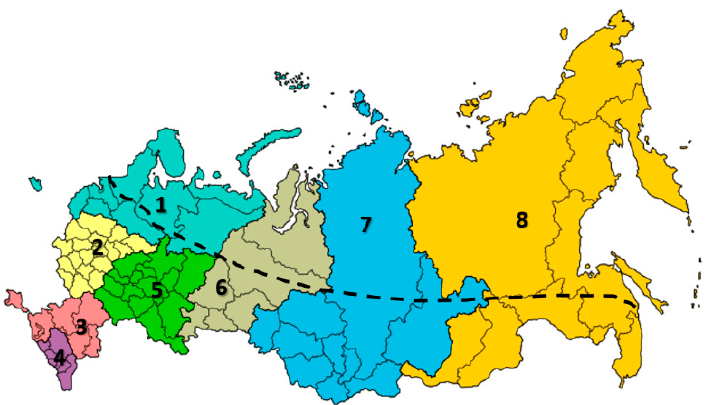
Figure 1. Federal districts in the Russian Federation. 1, North Western 9.87% (light blue); 2, Central 3.8% (yellow); 3, South 2.62% (pink); 4, North Caucasian 1.51% (purple); 5, Volga 6.07% (green); 6, Ural 10.62% (gray); 7, Siberian 25.50% (dark blue); 8, Far East 42.00% (orange). Border line: above the line is the northern zone of the Russian Federation. Honey bees are not present in the northern zone of the Ural district [56].